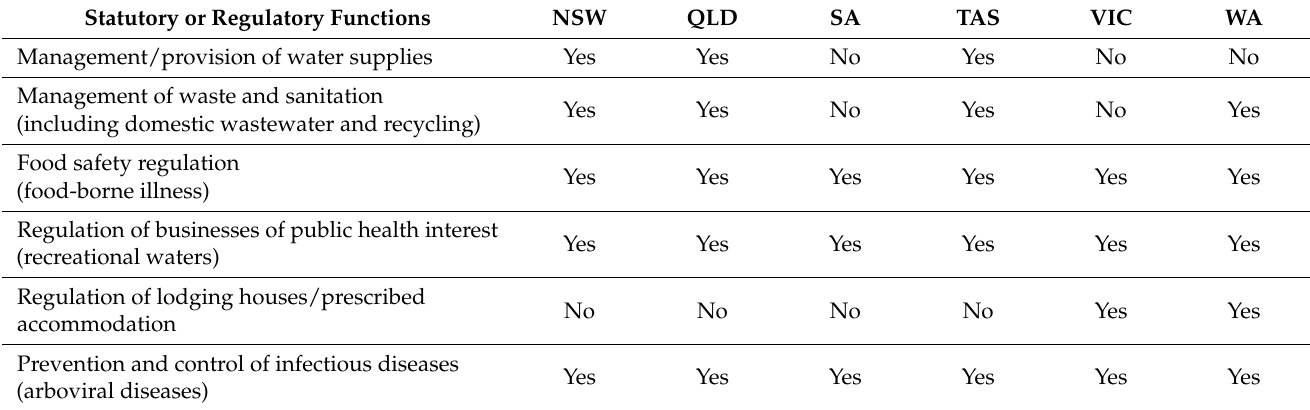
Table 1. Local government statutory health protection functions by the different Australian states (New South Wales (NSW), Queensland (QLD), South Australia (SA), Tasmania (TAS), Victoria (VIC), and Western Australia (WA)). (Adapted from Lin et al.